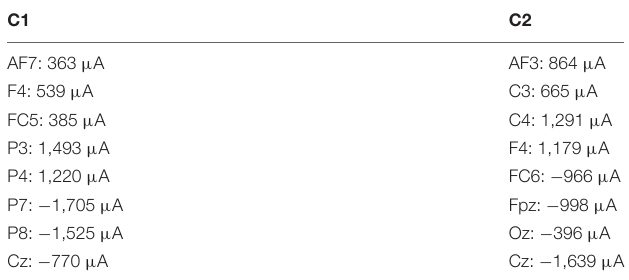
TABLE 1 | Electrode positions and current intensities in C1 and